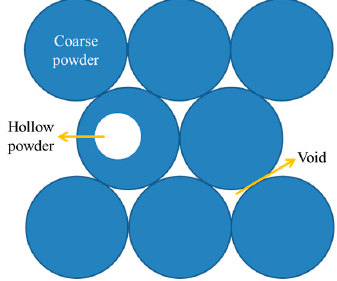
Figure 5. Relative density of multi-layer fabrication.